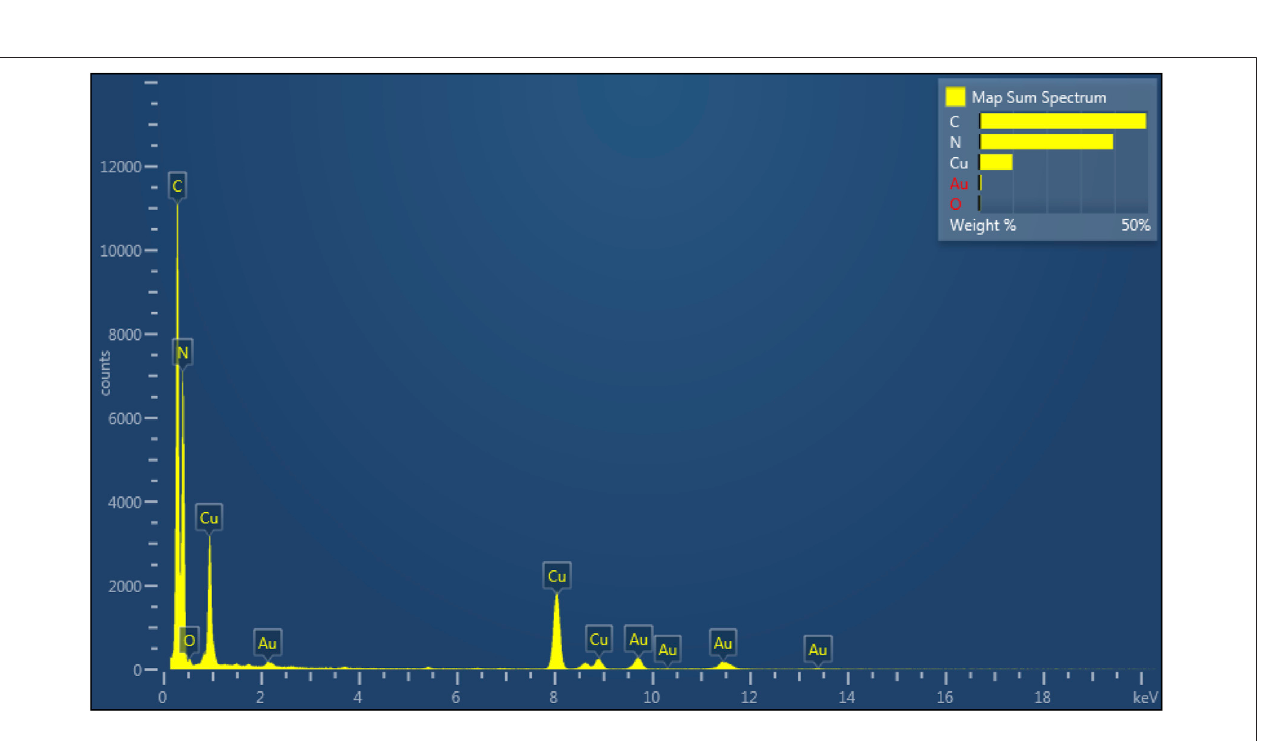
Frontiers in Chemistry |